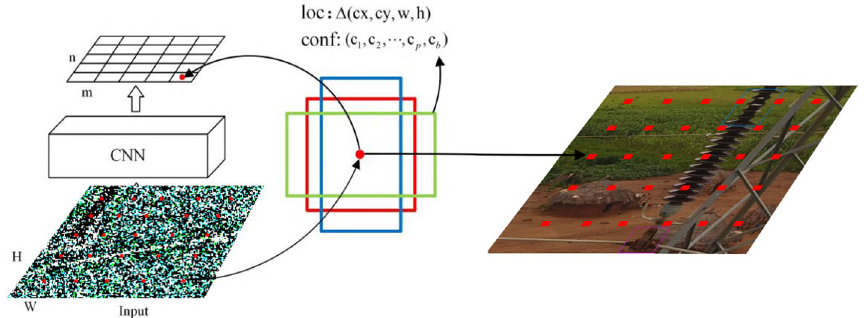
Fig. 9 The default boxes generation for one cell over the backbone network feature